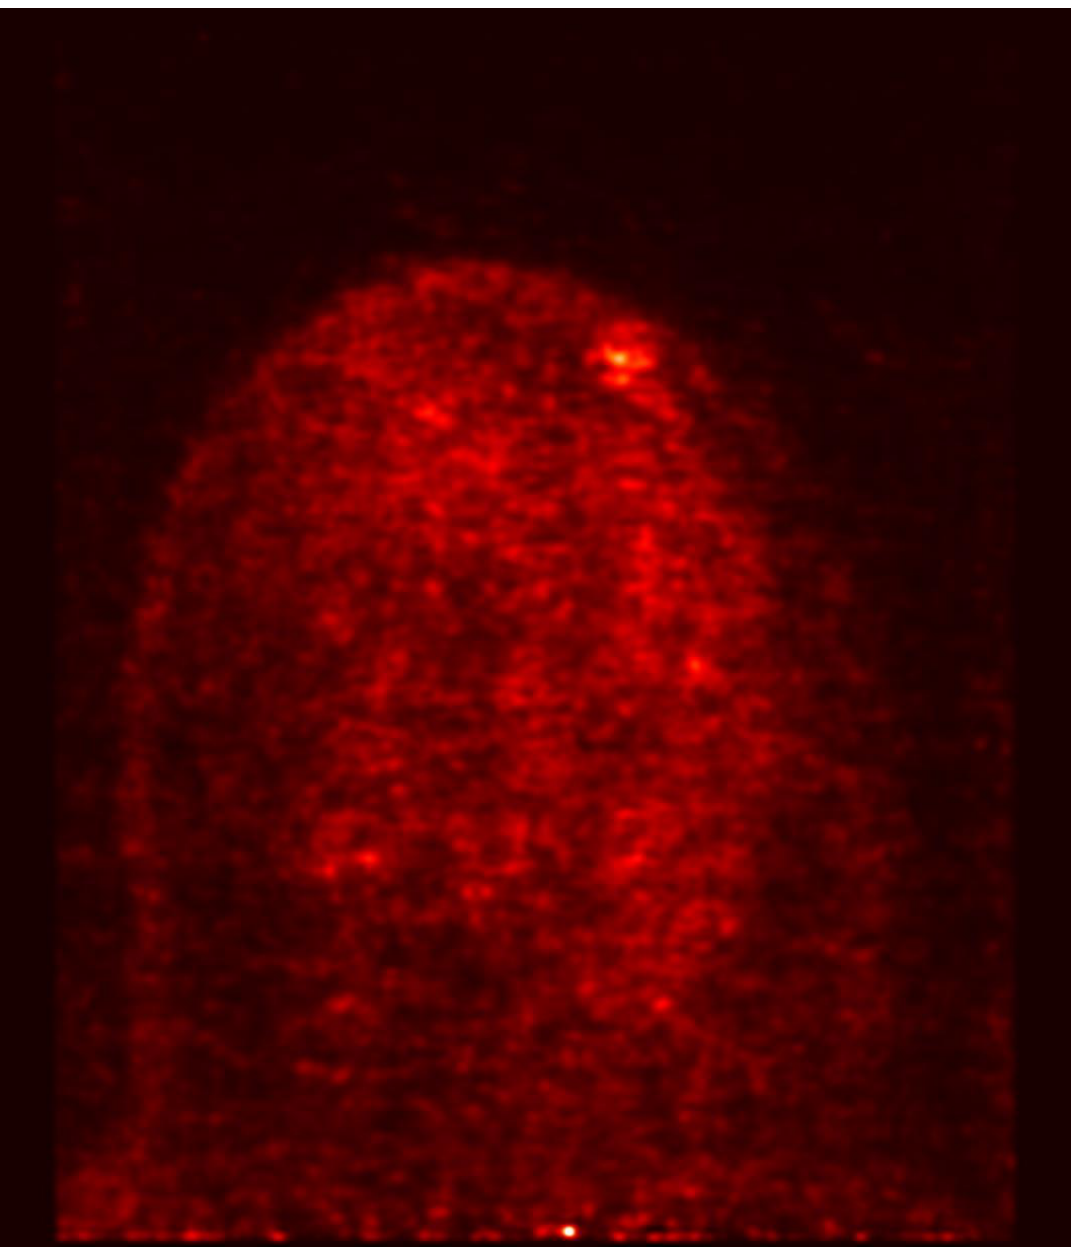
Figure 5. PET- MAMMI, focus of moderate uptake in the left breast in a patient with biopsy proven fibroadenoma.